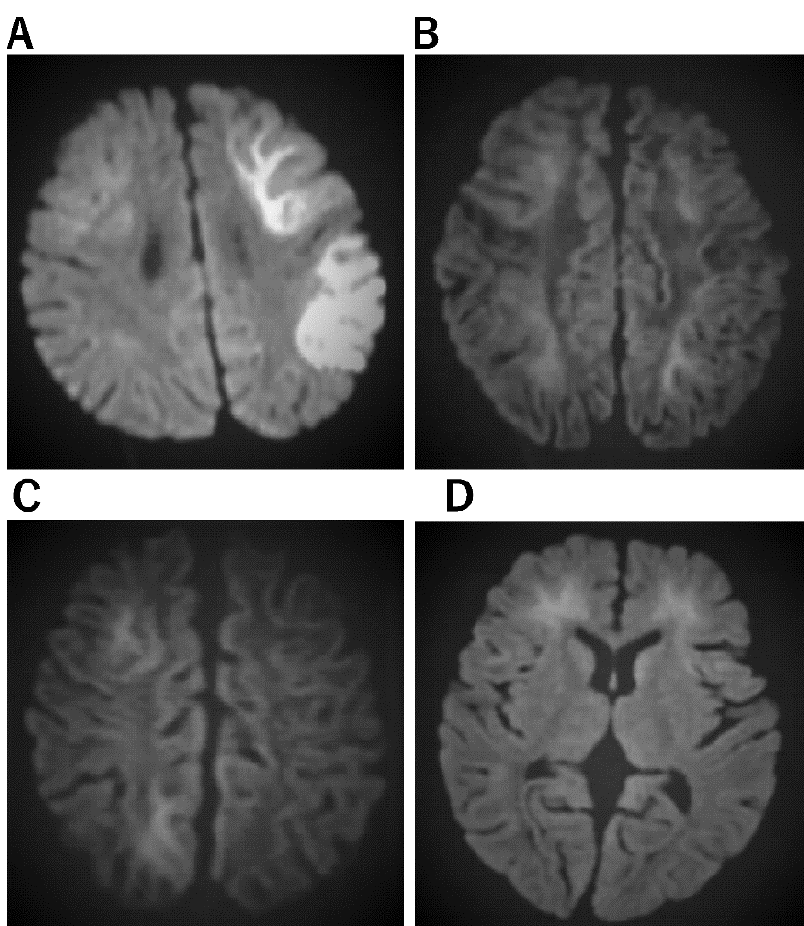
Figure 3. Imaging characteristics of AESD. ( A ) An 11-month-old boy who was admitted to the hospital with a high fever and 15 min seizure congestion of the right upper and lower extremities. The